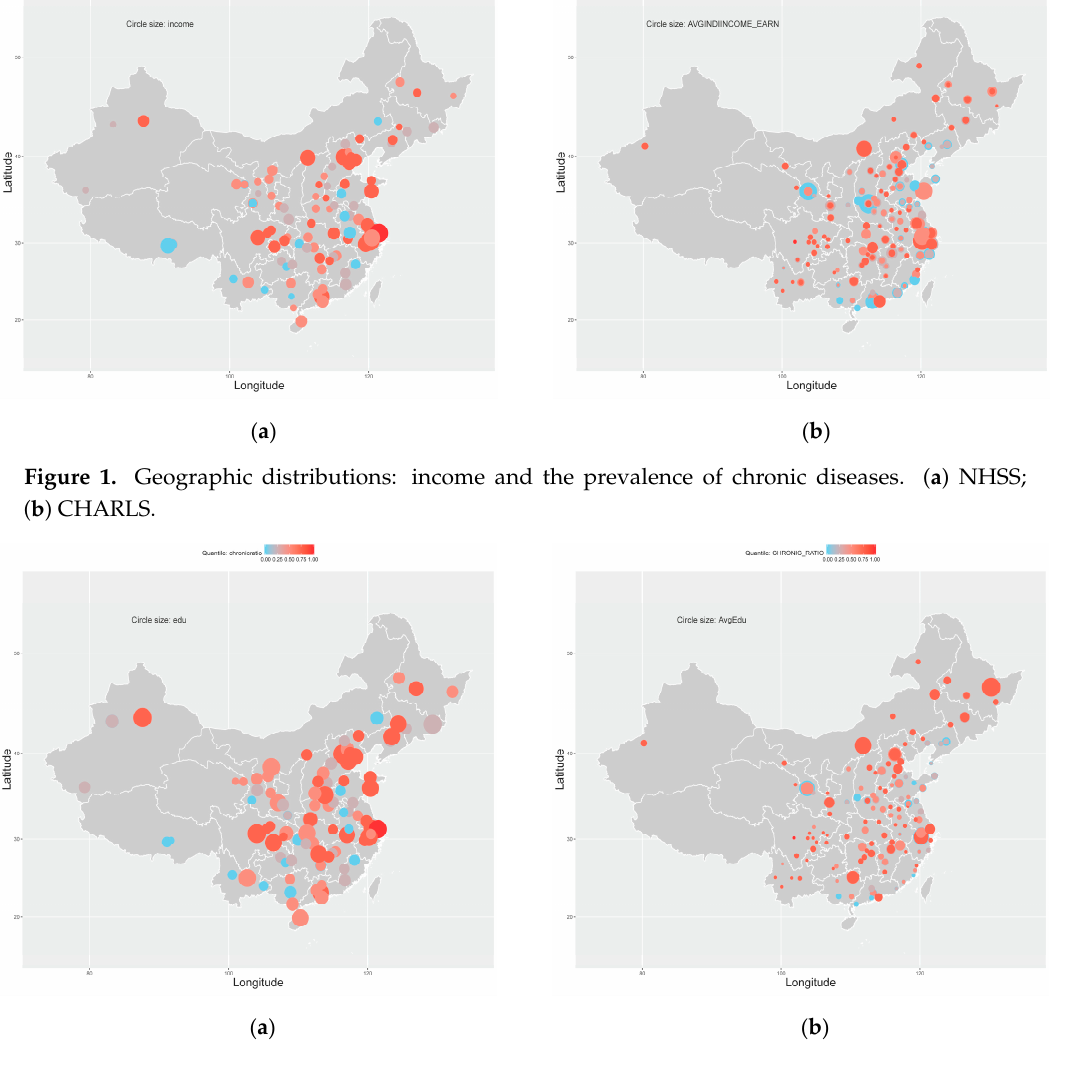
Figure 2. Geographic distributions: average education years and the prevalence of chronic diseases. ( a ) NHSS; ( b ) CHARLS.